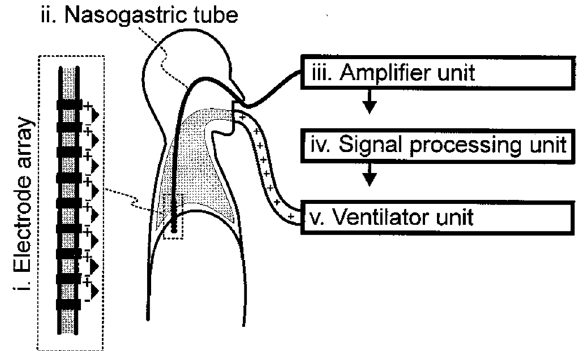
Figure 1. Description of the setup for measurement of the electrical activity of the diaphragm. Electrode array arrangement (i) attached to a nasogastric tube (ii) normally used for feeding or other purposes. The electrode array is positioned in the esophagus at the level of end perpendicular to the crural diaphragm such that the active muscle creates an electrically active region around the electrode. Signals from each electrode pair on the array are differentially amplified (iii) and digitalized into a personal computer and filtered (iv) to minimize the influence of cardiac electrical activity, electrode motion artifacts, and common noise, as well as other sources of electrical interference. The processed signal’s intensity value is displayed for monitoring purposes or fed to the ventilator (v) to control the timing and/or levels of the ventilator assist. Reprinted by permission from Springer Nature 5